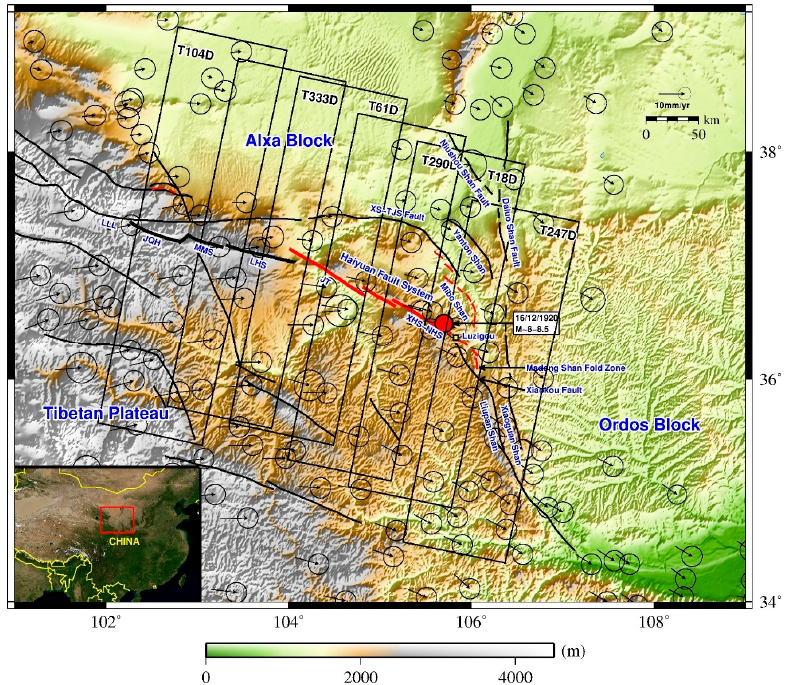
Figure 1. Tectonic map of the northeastern margin of the Tibetan Plateau. The major Haiyuan fault system is composed of several segments: LLL Leng Long Ling, JQH Jing Qiang He, MMS Maomao Shan, LHS Laohu Shan, JT Jing Tai, XHS-NHS Xihua Shan-Nanhua Shan, XS-TJS Xiang Shan-Tianjing Shan. The thick black solid lines indicate active faults in Holocene. The red solid circle represents the epicenter of the 1920 earthquake; the red solid lines show its surface rupture. Black rectangles show the coverage of Envisat ASAR data, with track numbers indicated. GPS data with respect to the Eurasia-fixed Reference Frame is from Gan et al. [22].